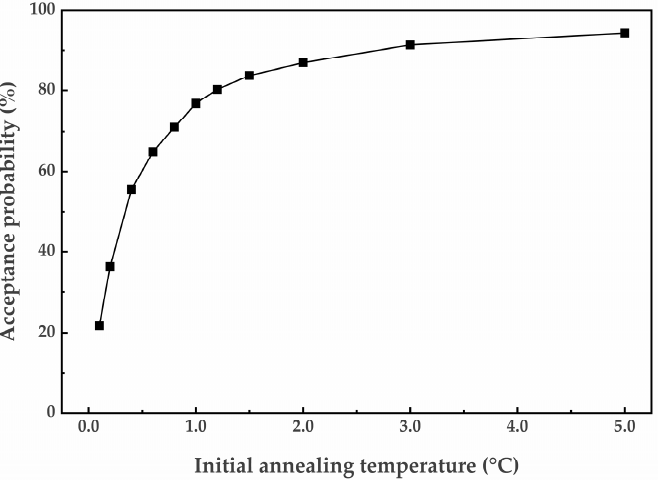
Figure 3. Relationship between initial annealing temperature and acceptance probability of worse solution.